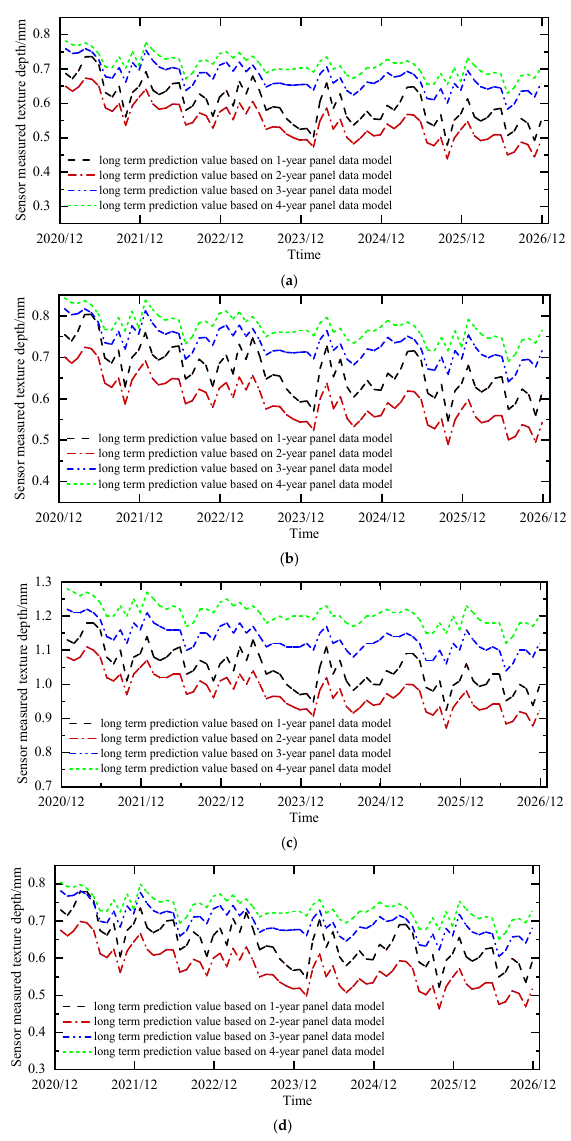
Figure 9. Predicted SMTD results for year 2021 to 2026 for different time scales of panel data analysis-based model. ( a ) SRT-14 (Dense-graded asphalt concrete, SAC13-65%). ( b ) SRT-7 (Dense-graded asphalt concrete, SAC13-70%). ( c ) SRT-9 (Porous asphalt concrete, PAC13-80%) ( d ) SRT-19 (Dense-graded asphalt concrete, SMA13-75%).